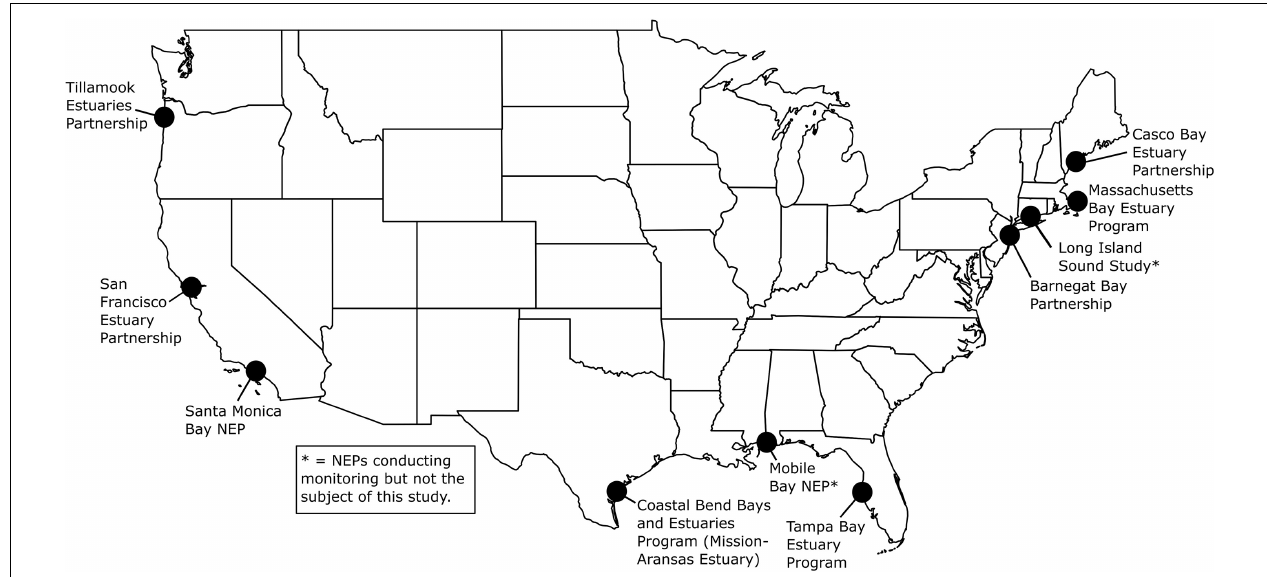
FIGURE 1 | United States Environmental Protection Agency’s (EPA’s) National Estuary Programs (NEPs) with coastal acidification monitoring data included in this study. See Figure 2 for more details on deployments. Mobile Bay NEP, Long Island Sound Study and Massachusetts Bay NEP (denoted with asterisks) are conducting monitoring but are not the subject of this study. Map created by